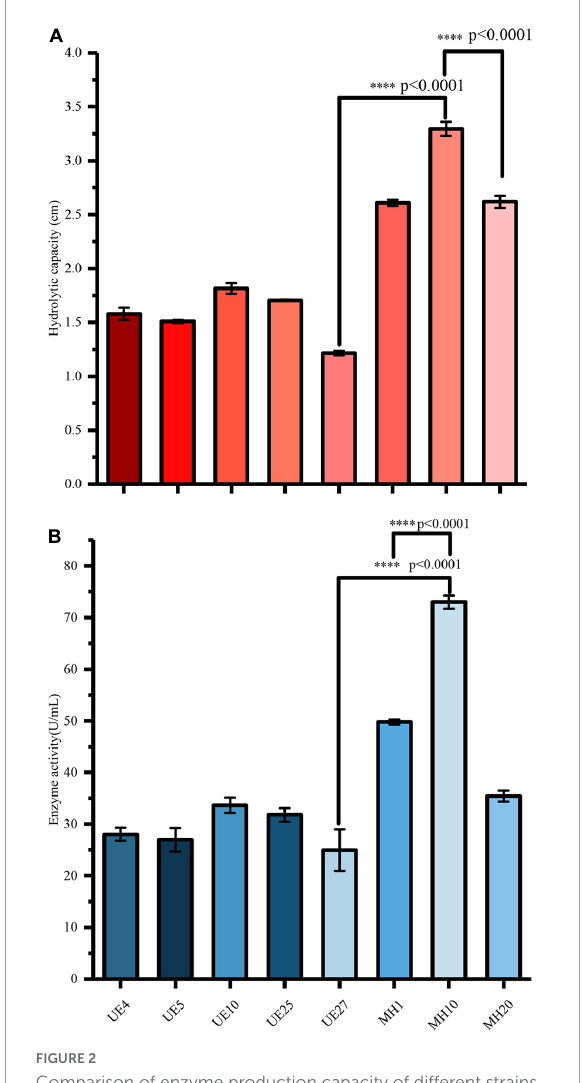
FIGURE2 Comparison of enzyme production capacity of different strains exhibiting cellulase hydrolysis (A) and cellulase activity (B) . ∗∗∗∗ p -value <